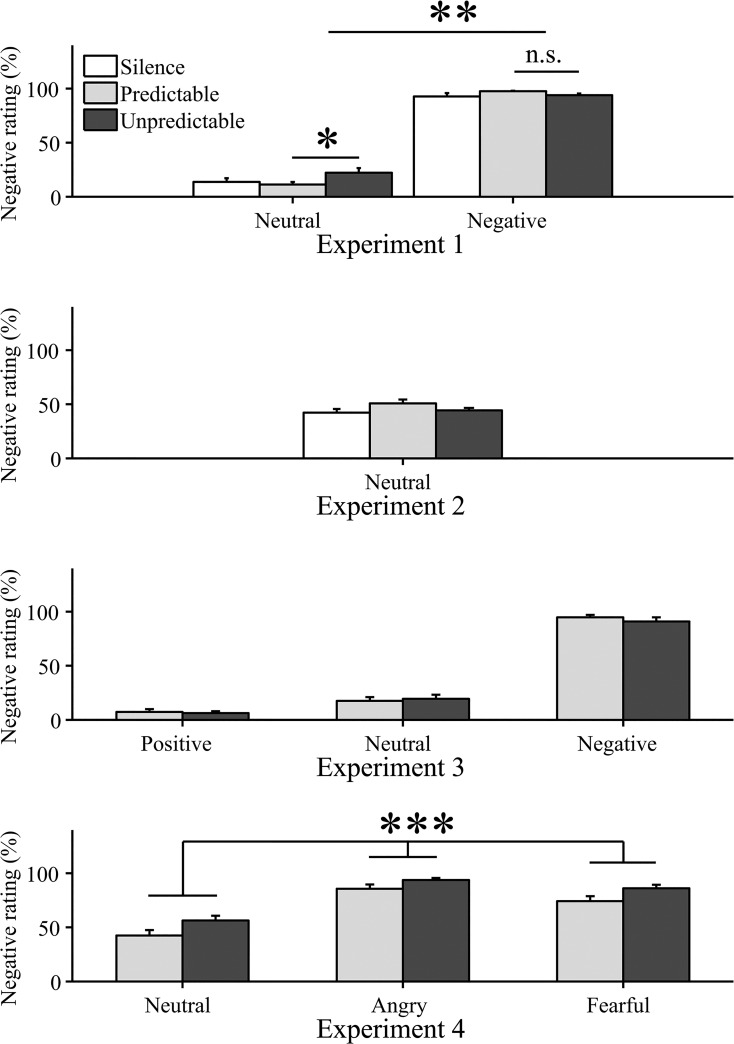
Stimulus ratings (mean ± standard error) for different pictures during silence, predictable, and unpredictable sound sequence.* p < .05, ** p < .01, *** p < .0005.